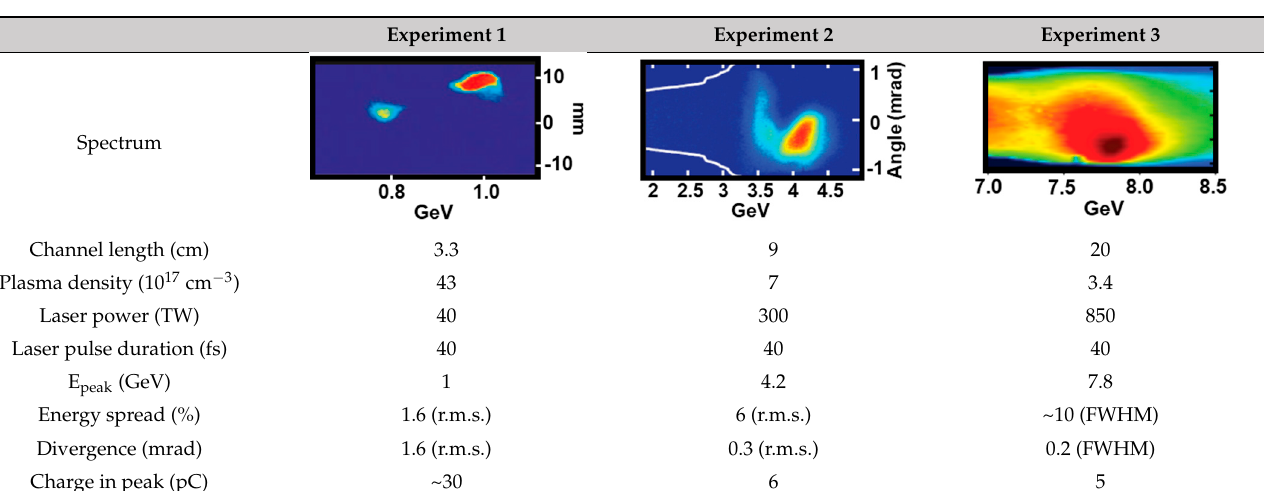
Table 2. Characteristics of electron beams from capillary discharge plasma channel and experimental condition for three different experiments with laser power of 40 TW [37], 300 TW [19], and 850 TW [12]. Reproduced with permission from